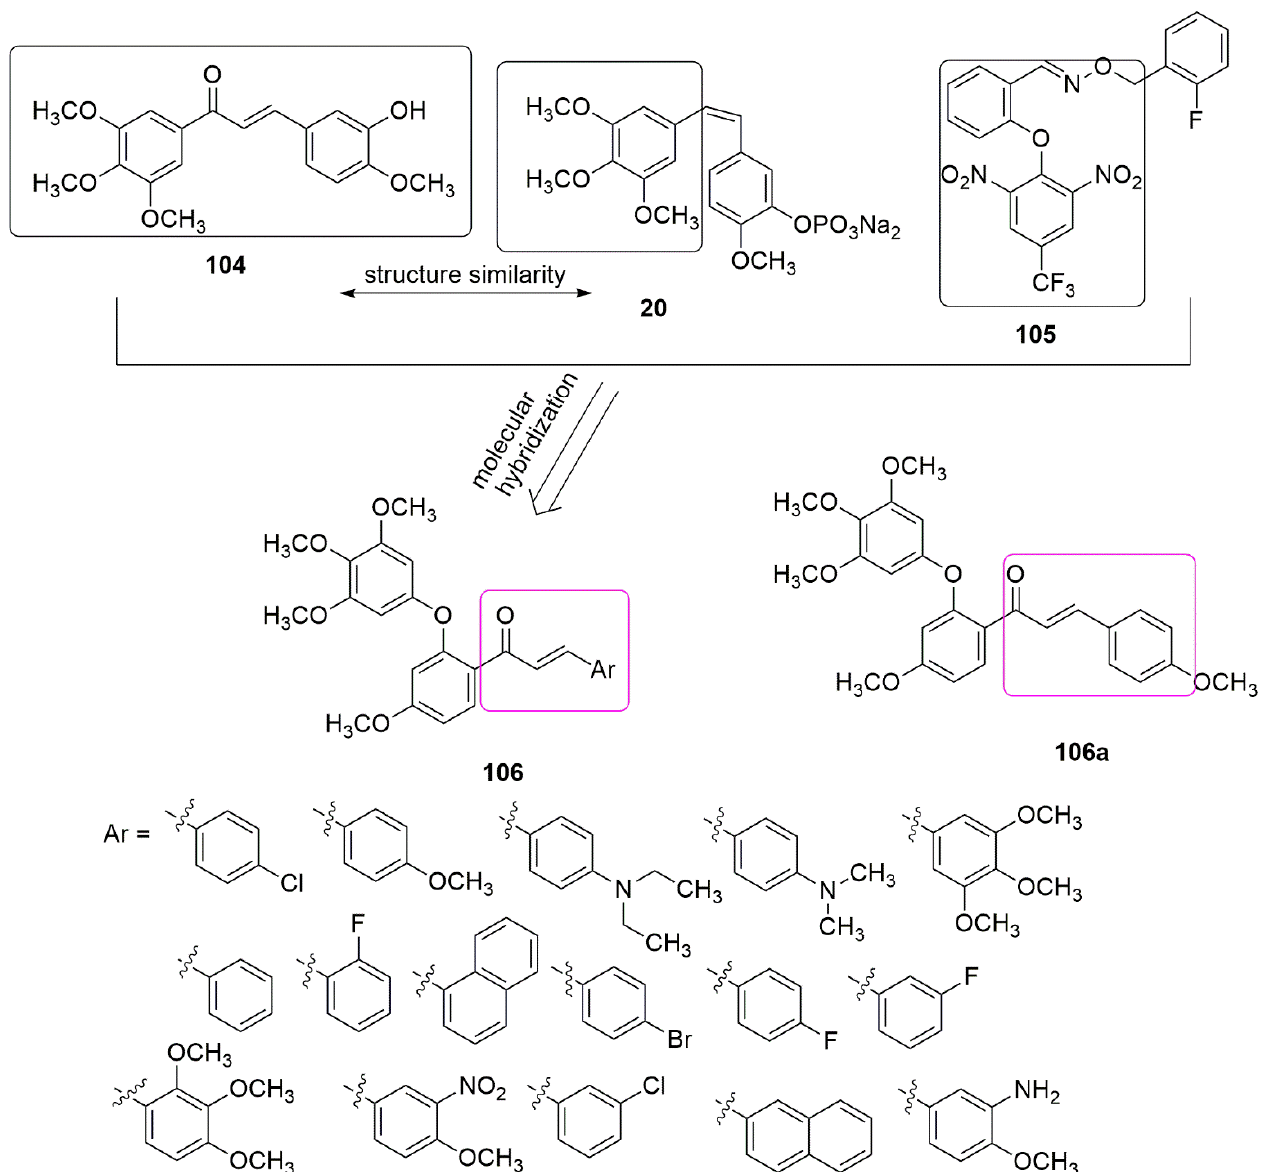
Figure 31. Chemical structures of tubulin polymerization inhibitor bearing chalcone, and diaryl ether hybrids.